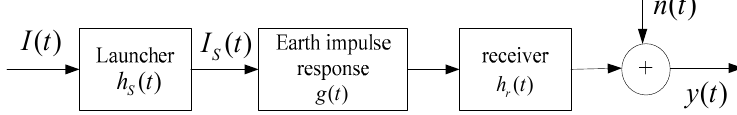
Figure A1. Schematic diagram of geoelectric correlation identification system.